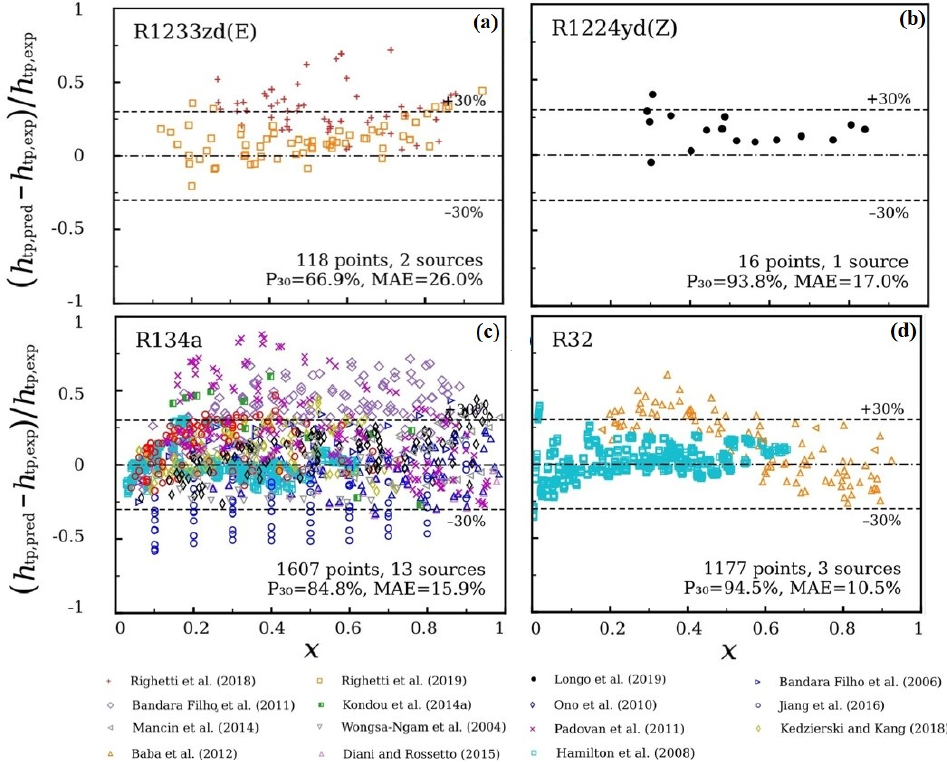
Figure 11. Comparison of different models on the basis of relative residuals to Lin et al. [120] model versus vapor quality for refrigerants ( a ) R1233zd(E), ( b ) R1224yd(Z), ( c ) R134a, and ( d ) R32.